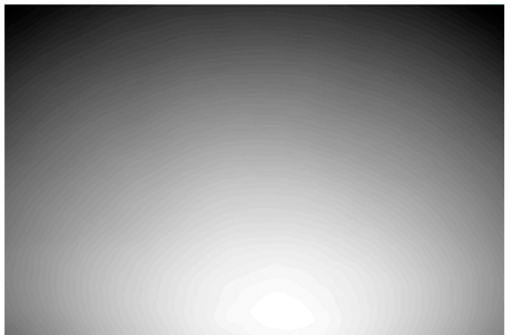
Figure 6. The background light for the image in Figure 5, extracted by median filtering in a neighborhood of 55 pixels radius.